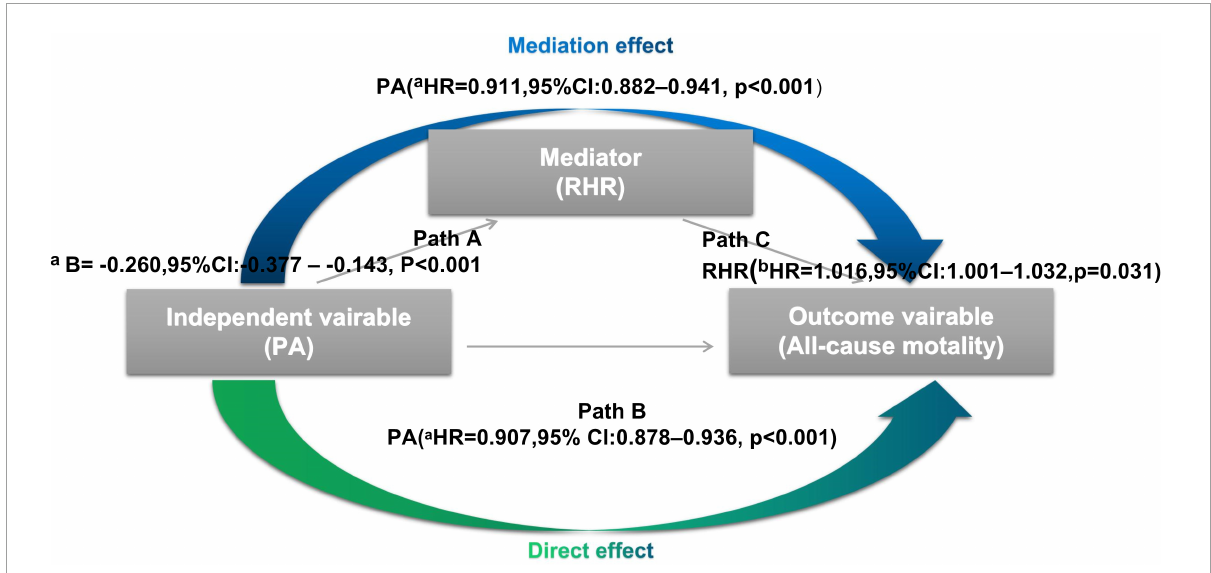
FIGURE1 Processes of the causal mediation analysis In Path A, there is a significant linear relationship between physical activity (PA) (independent variable) and resting heart rate (RHR) (mediator) by the multiple regression model. In Path B, PA (independent variable) is shown as an independent predictor for all-cause mortality (outcome variables) in the multivariable Cox regression model without RHR. In Path C, RHR (mediator) can also be an independent predictor for all-cause mortality in the multivariable Cox regression model 2 where the mediator (e.g., PA) were included. CI, confidence interval; HR, hazard ratio; PA, physical activity; RHR, resting heart rate. a Each additional 1% increase in PA. b Each additional 1 beats increase in RHR.